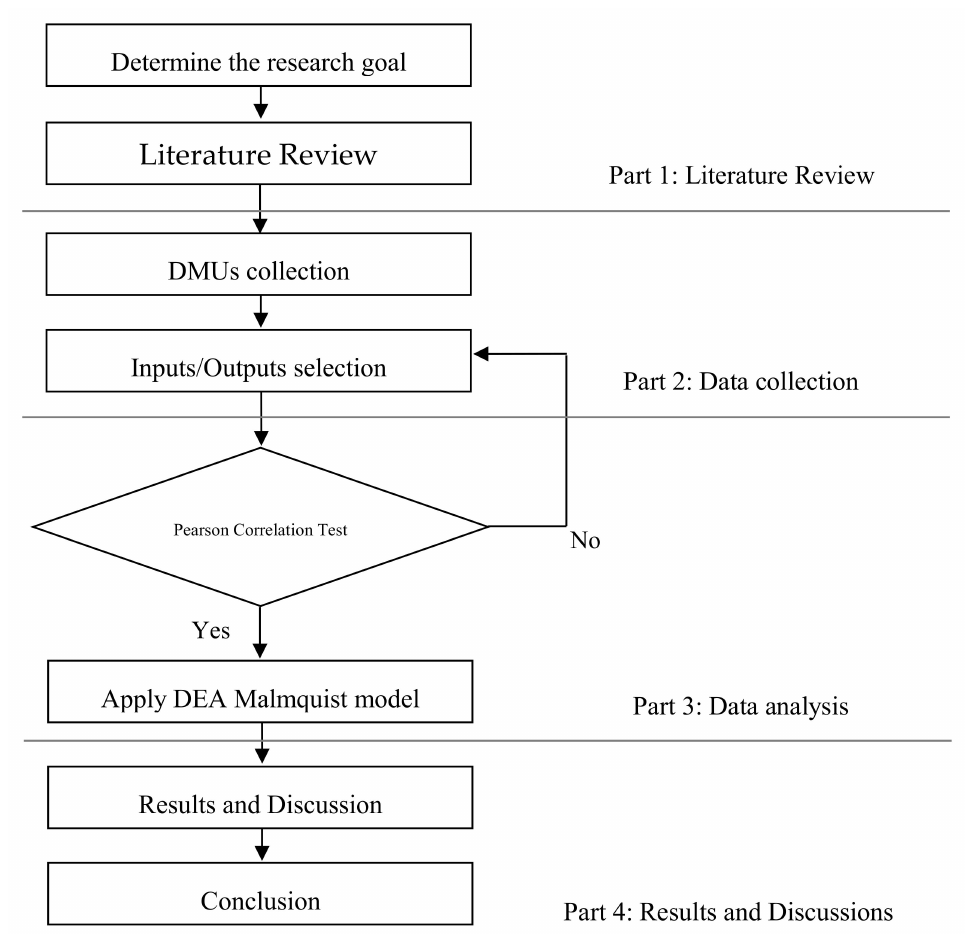
Figure 1. Procedures of